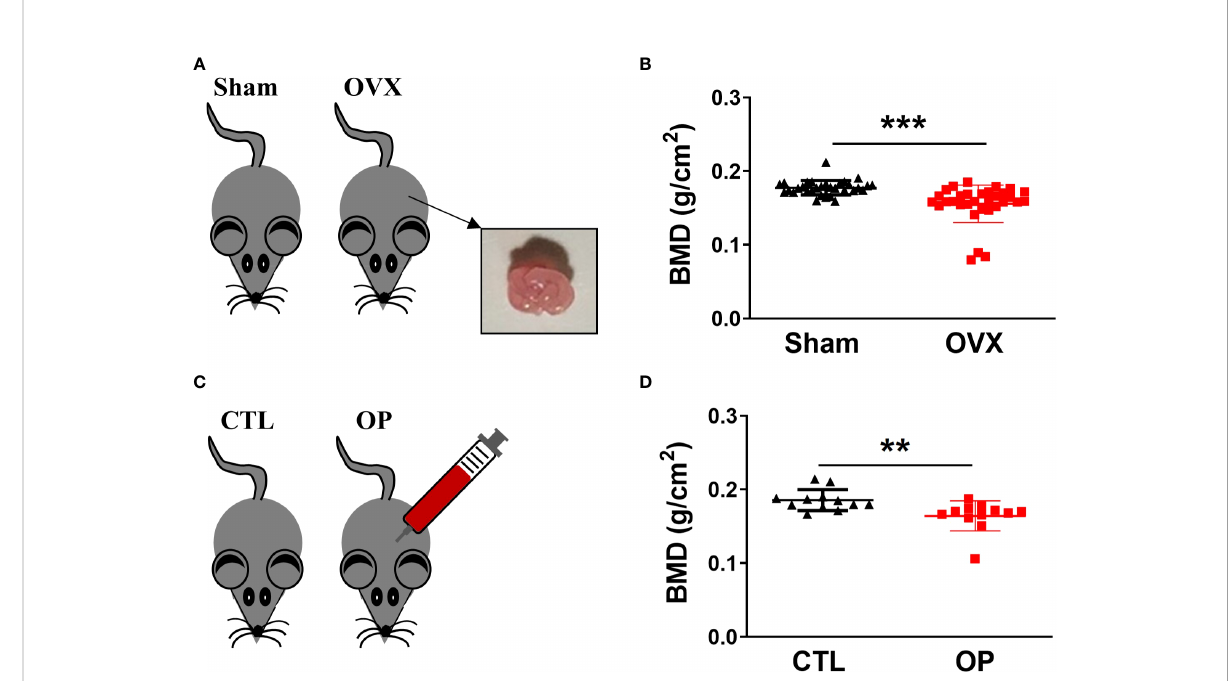
FIGURE 1 Construction of osteoporotic mice and identi fi cation of BMD. (A) Estrogen de fi ciency-related osteoporotic mouse models were constructed via bilateral ovariectomy (OVX) operation. (B) The whole body of BMD in estrogen de fi ciency-related osteoporotic mice was measured using dual energy-ray absorptiometry. n = 32. (C) Iron overload-induced osteoporotic mouse models were established via intraperitoneal injection of iron dextran. (D) Measurement of BMD in iron overload-induced osteoporotic mice. n=12. ** p <0.01, *** p <0.001 versus sham or CTL. Sham, sham operation group; OVX, ovariectomy operation group; CTL, control group; OP, overload-induced osteoporotic group. BMD, bone mineral